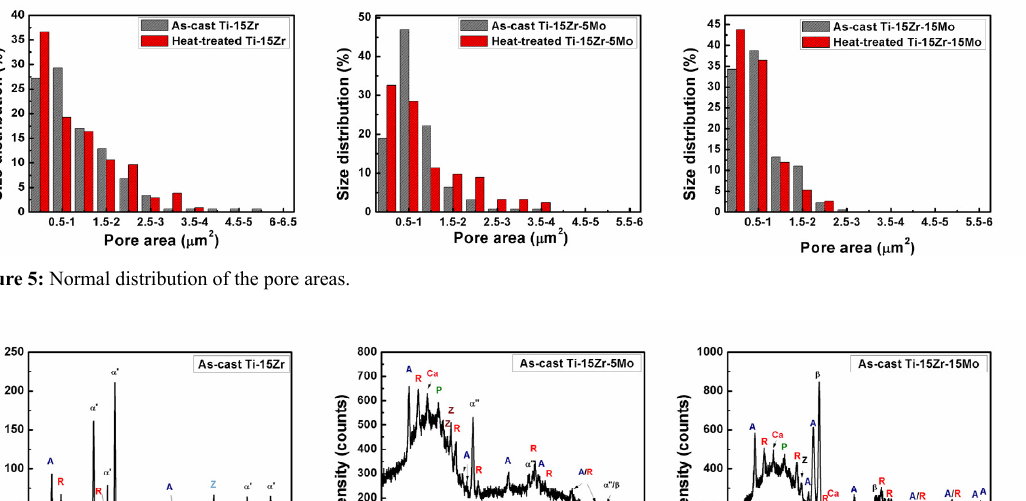
Figure 6: XRD patterns of MAO treated samples (A – anatase; R – rutile; Z – tetragonal zirconia; Ca – CaCO